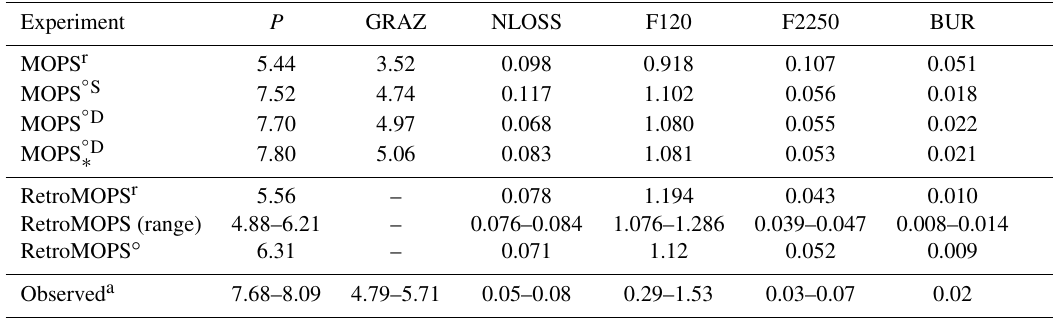
Table 4. Global annual fluxes of primary production ( P ), grazing (GRAZ), fixed nitrogen loss through pelagic denitrification (NLOSS), export production (F120, flux through 120m), flux through 2250m (F2250) and benthic burial (BUR), in PgNyr − 1 , for the reference ◦ S ◦ D ◦ D experiment of MOPS r , MOPS , MOPS , MOPS ∗ and RetroMOPS, for which we show the fluxes of the (best) reference experiment, RetroMOPS r , the range of all sensitivity experiments, and the optimised run, RetroMOPS ◦ . Also shown are some globally derived observed estimates. Conversion between different elements was carried out via N : P = 16 and C : P =